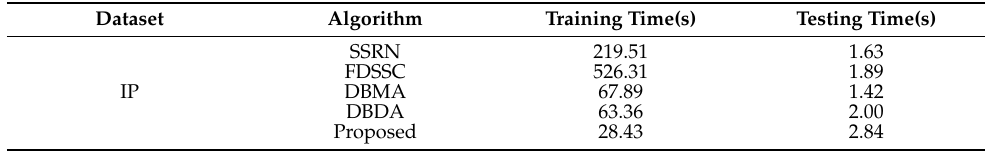
Table 11. Training and testing time consumption for the IP